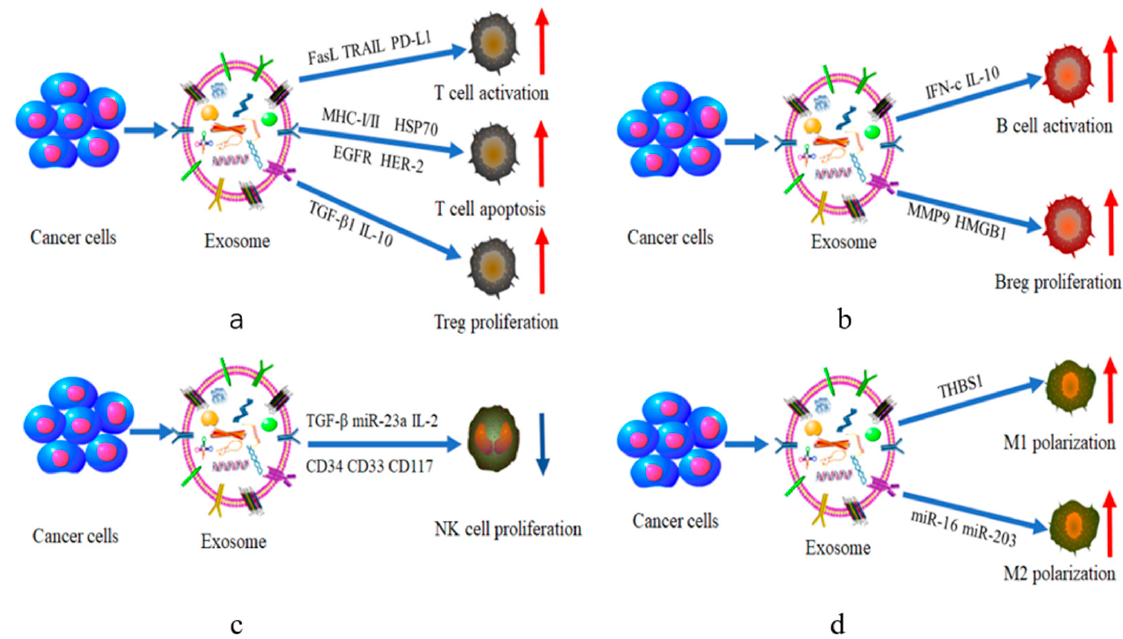
Figure 2. The effect of tumor-derived exosomes on immune cells. ( a – d ) respectively show the regulatory effects of various signal molecules of tumor-derived exosomes on the proliferation and differentiation of T cells, B cells, NK cells and macrophages. (MHC-I(II), major histocompatibility complexes; HSP70, heat shock protein70; EGFR HER-2, growth factor receptors; FasL TRAIL PD-L1, tumor necrosis factor–related apoptosis-inducing ligand; TGF- β , transforming growth factor β ; IL-10, Interleukin-10TGF- β , transforming growth factor β ; CD34 CD33 CD117, NK cells receptors; IFN-c, pro-inflammatory factors; IL-10, anti-inflammatory factors; MMP9, matrix metalloproteinase 9; HMGB1, an evolutionarily conserved DNA-binding nuclear protein; THBS 1, a protein with strong anti-inflammatory properties).